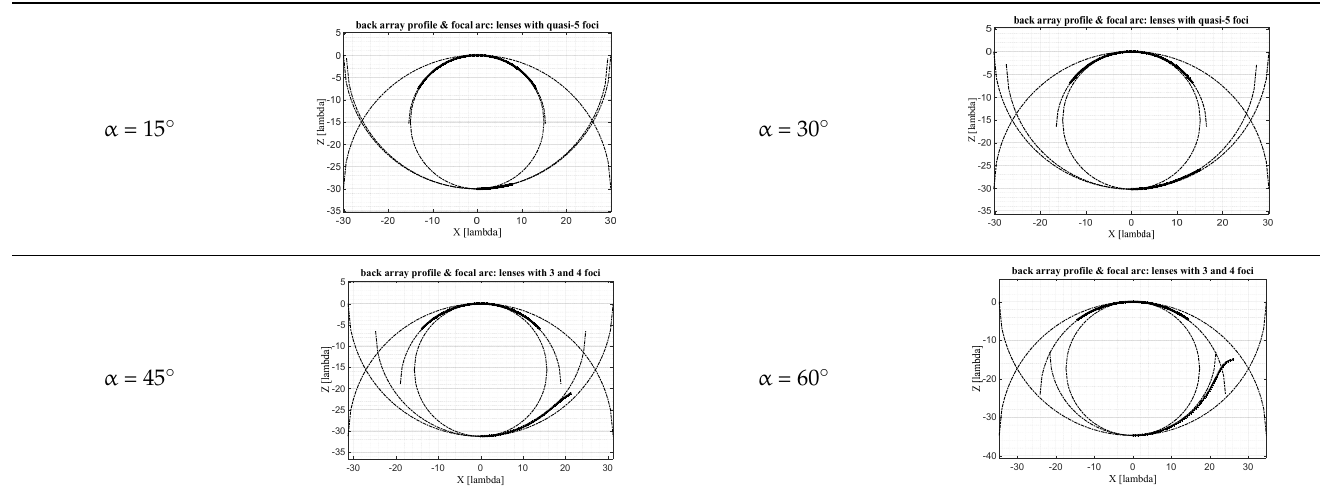
Table 7. Focal arc vs. back lens profile vs. circular shapes F/D = 1, zoom = 1, D = 30 λ -.